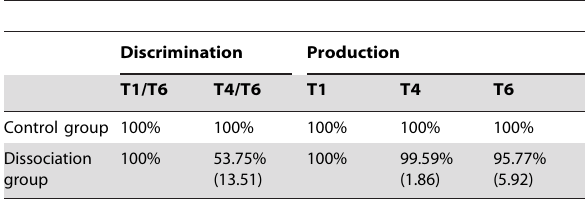
Table 1. Participants’ performance in mean ( SD ) in the tone discrimination and production